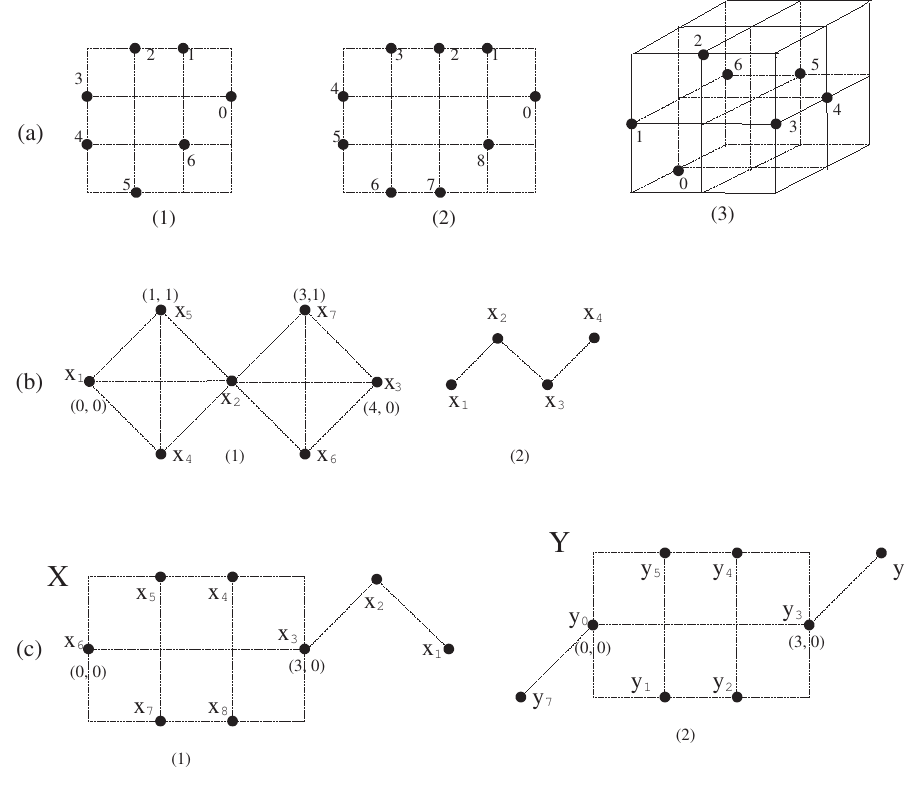
∨ C 2,4 (2) C 2,9 (3) C 3,7 . ( b ) (1) C 2,4 [3] (2) A simple 8-path with the length 3, where 8 8 8 8 18